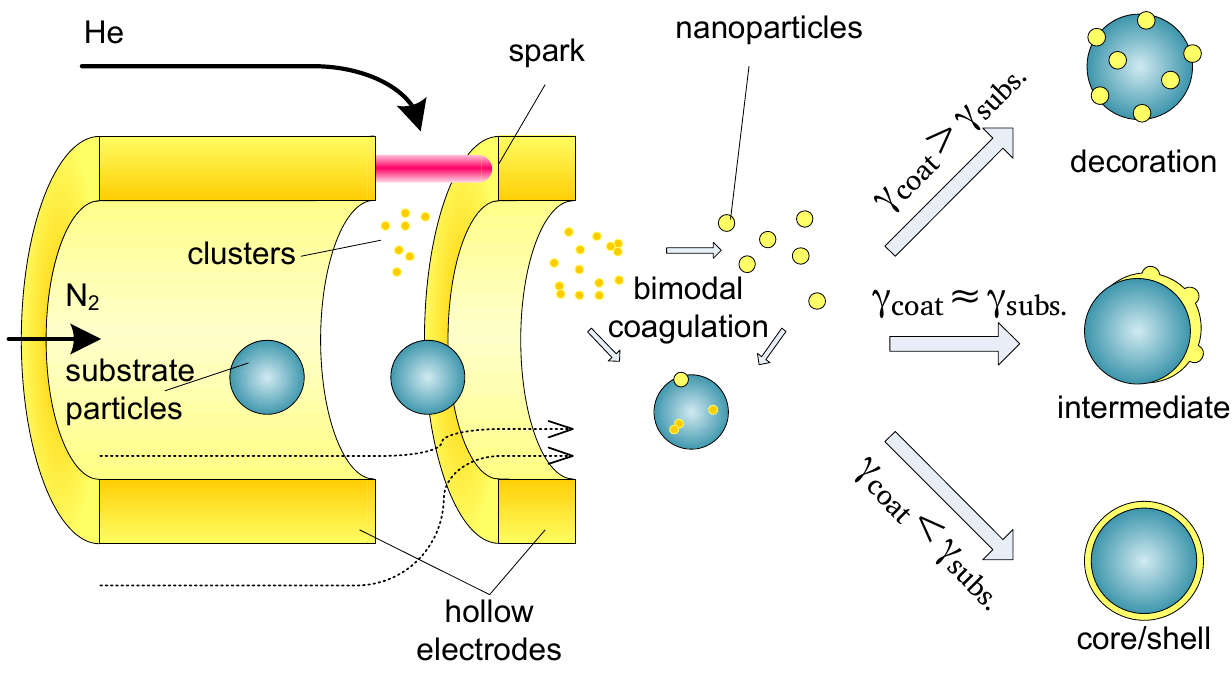
Figure 1. Schematic cross-section of the coating process in a hollow-electrode